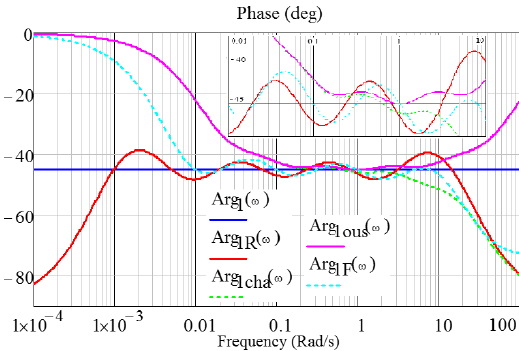
Fig. 11: Phase responses